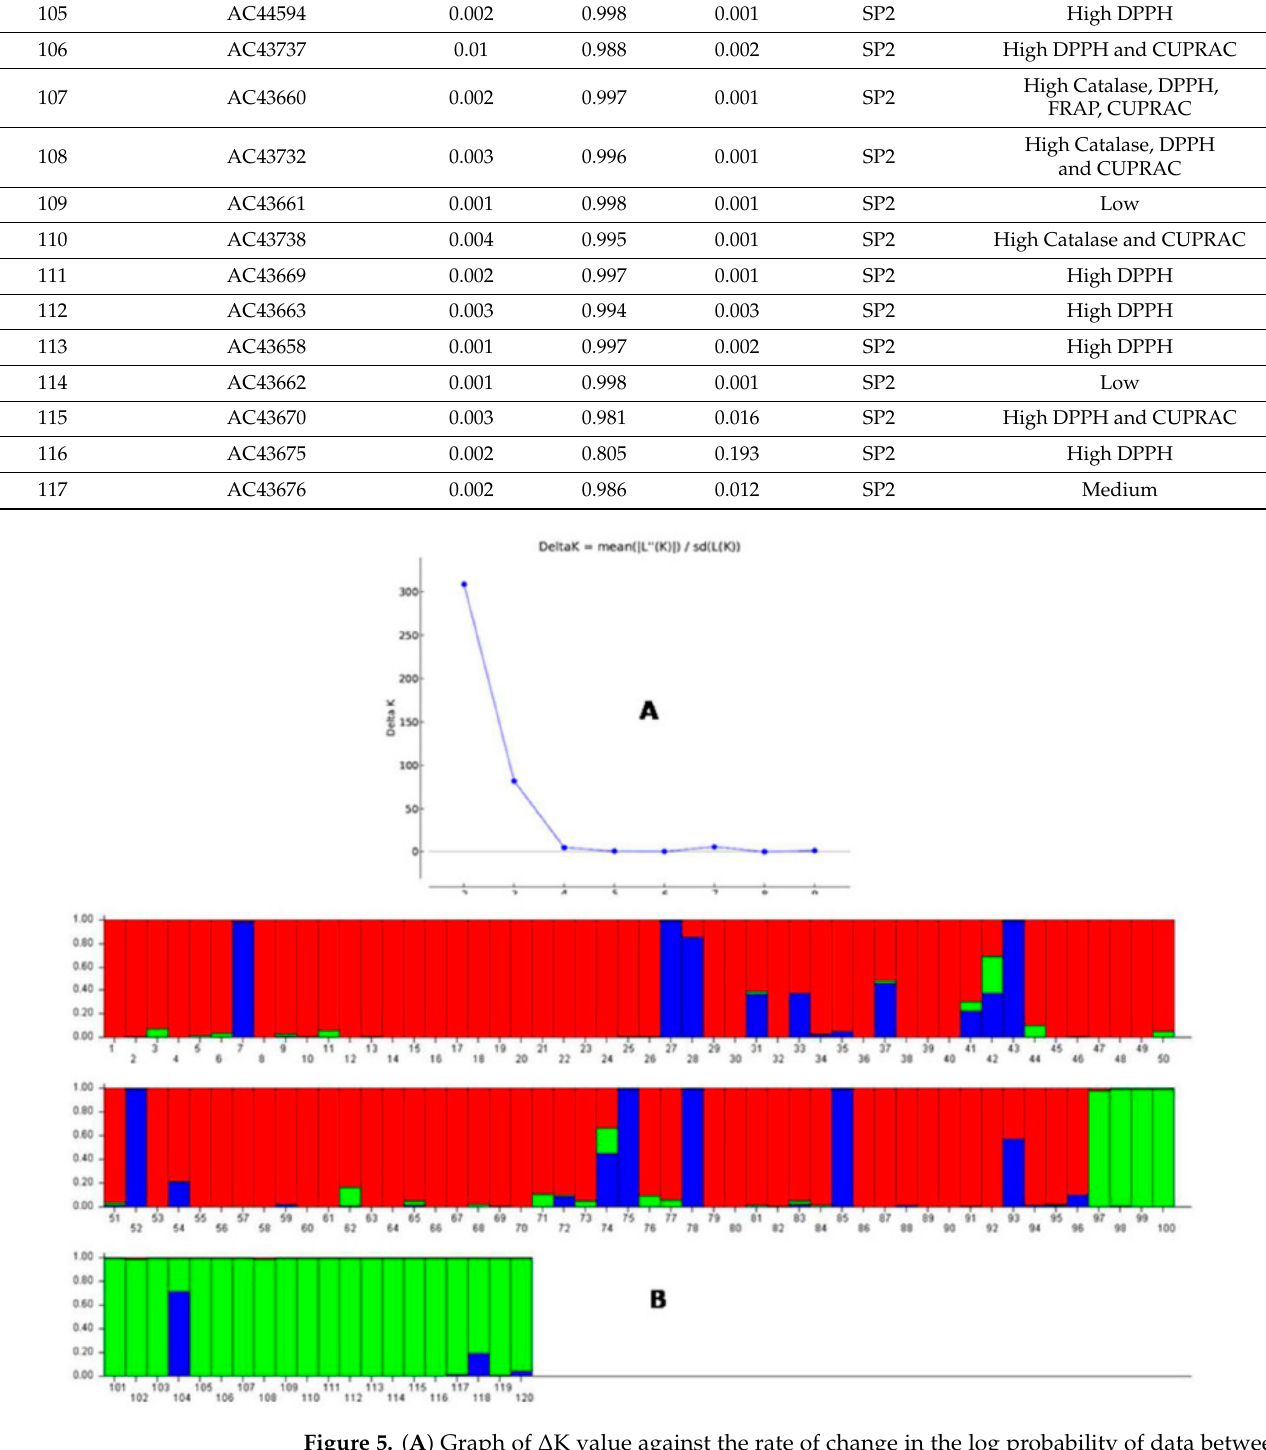
Figure 5. ( A ) Graph of ∆ K value against the rate of change in the log probability of data between successive K values. ( B ) Population structure of the panel population based on membership probability fractions of individual genotypes at K = 3. The genotypes with the probability of ≥ 80% of membership proportions were assigned as subgroups whereas others were grouped as the admixture group. The numbers in the diagram depict the serial number of the germplasm lines listed in Table